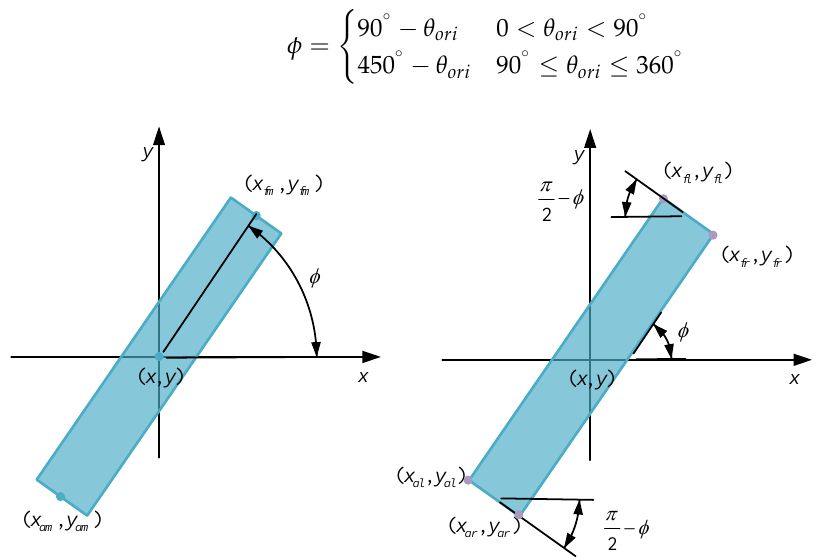
Figure 2. Geometric relationship diagram of ship size model vertices. are the abscissa and ordinate of the midpoint of the front and rear ends of the ship, respectively, which can be calculated using Equations (7) and (8). are the x axis − direction offsets of the top left, top right, bottom right, and bottom left vertices relative to the midpoint of the front and rear ends, respec- tively. Similarly, the offset in the y axis − direction can be calculated using Equations (9) and (10).